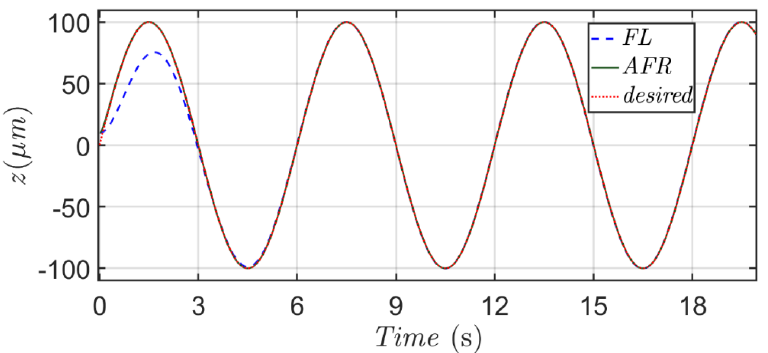
Figure 9. Micro-positioning results of output displacement z based on the proposed method (green line) and feedback linearization method (blue dash line) with respect to a desired sinusoidal trajec- tory .